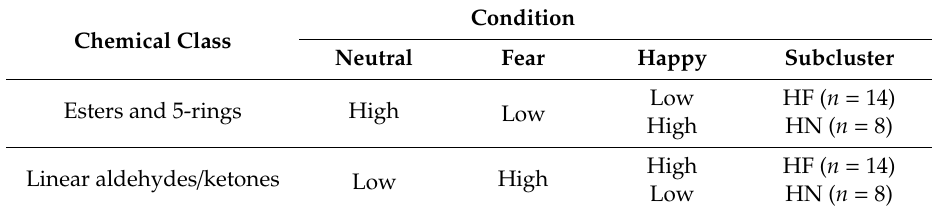
Table 2. Response pattern (high vs. low) of the two chemical compound classes by emotion condition (neutral, fear, and happy) with happy showing a bipolar pattern with individuals in subcluster HF overlapping with Fear pattern; in subcluster HN overlapping with Neutral. n = number of donors.